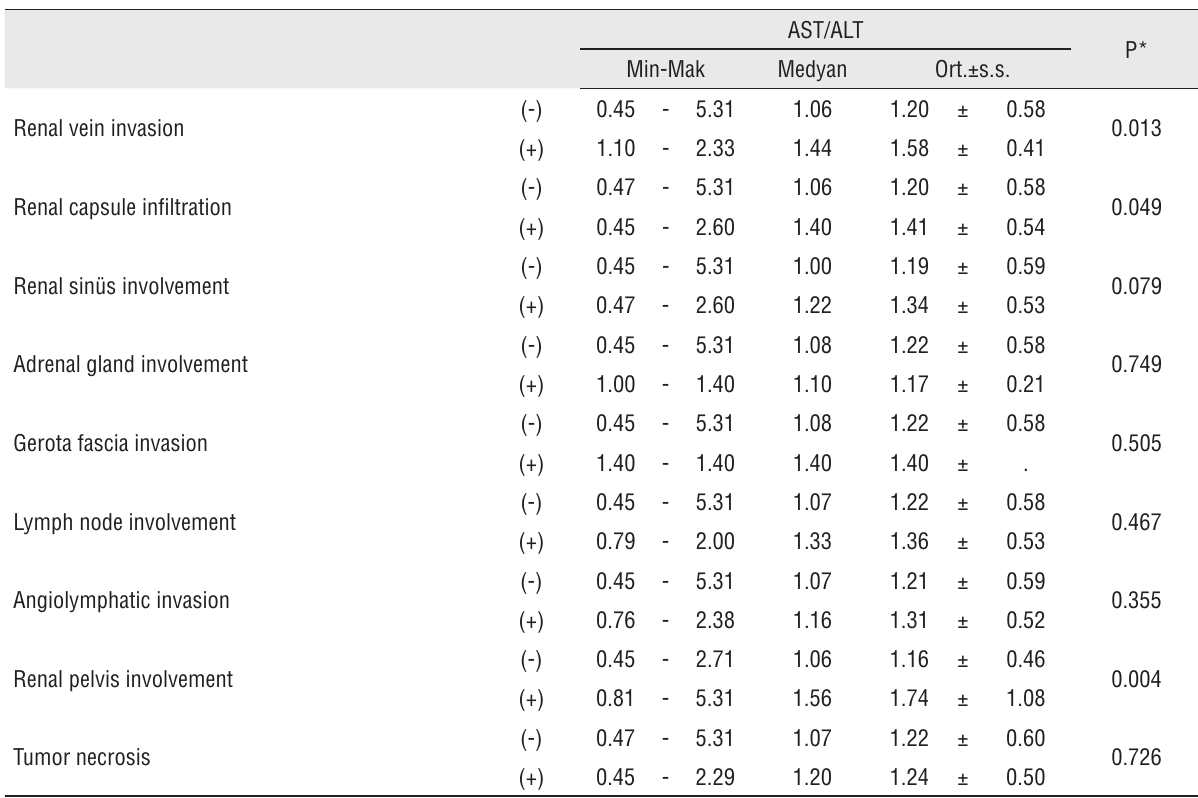
Table 3 - Association between AST/ALT ratio and histopathological